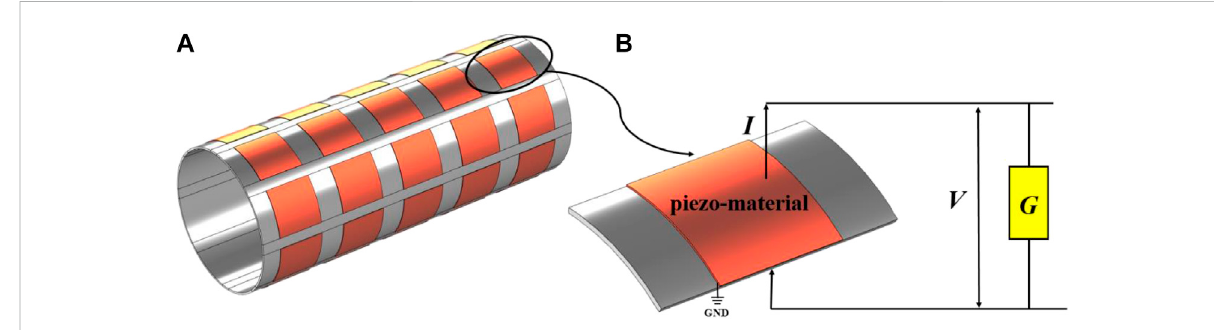
FIGURE 1 (A) Physical model of the cylindrical meta-shell with piezoelectric patches and digital circuits, (B) a unit-cell of the meta-shell, G indicates the digital circuit connecting to the patch.